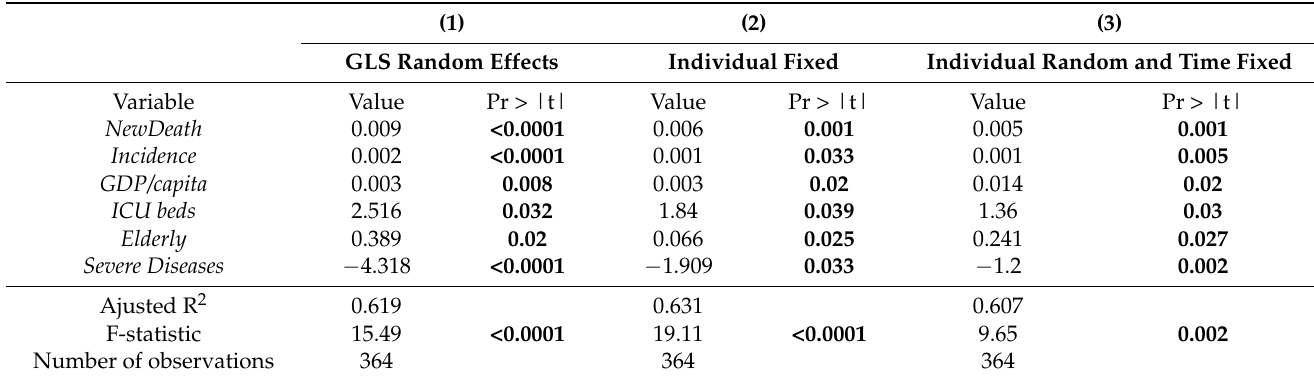
Table 4. Panel model: Results.